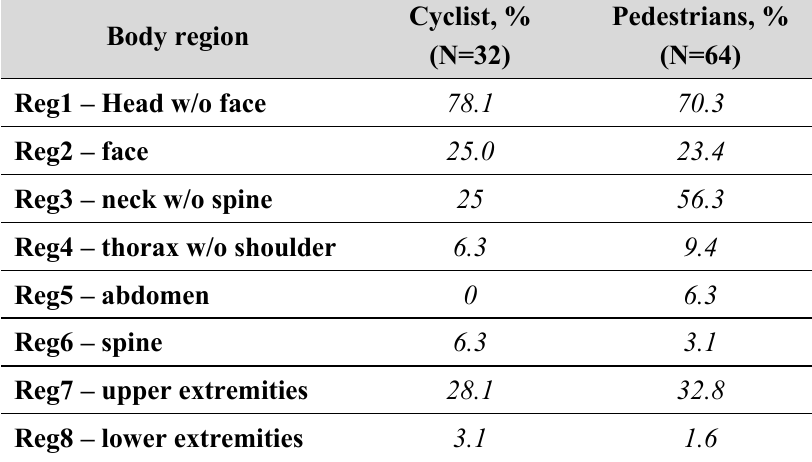
Table A5. Proportion of fatally injured cyclists and pedestrians sustaining fatal injuries in the listed body